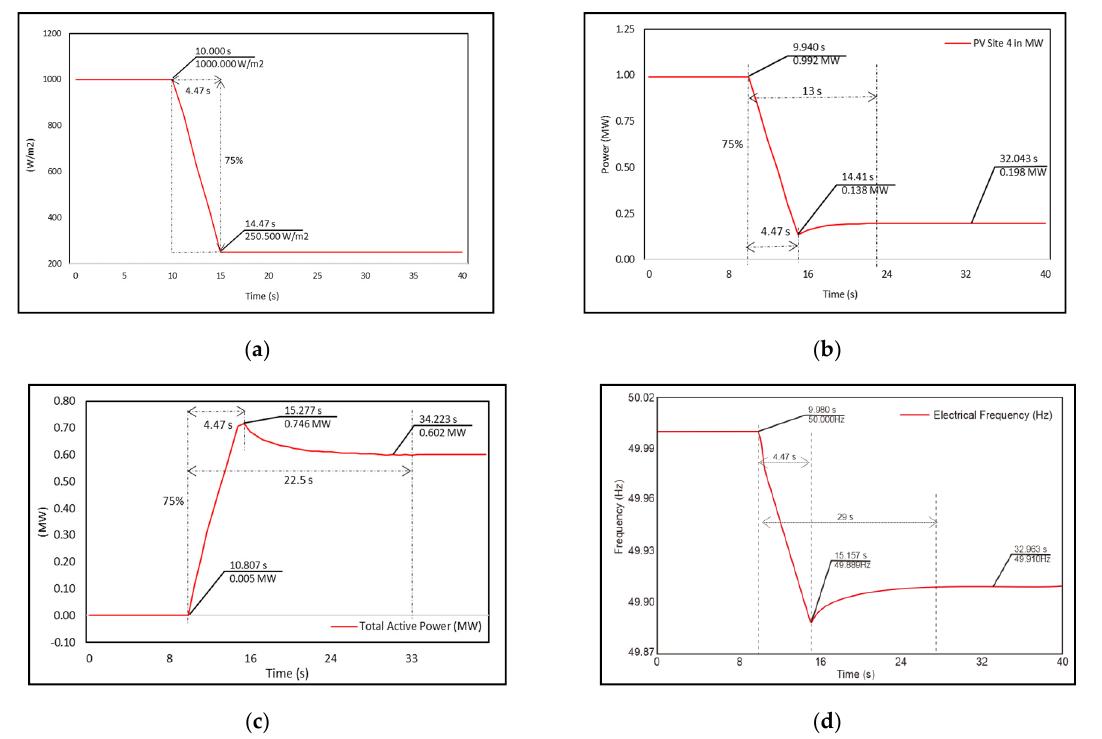
Figure 17. Respons system analysis; ( a ) PV system response; ( b ) PV active power response; ( c ) Battery system response; ( d ) Frequency system response.